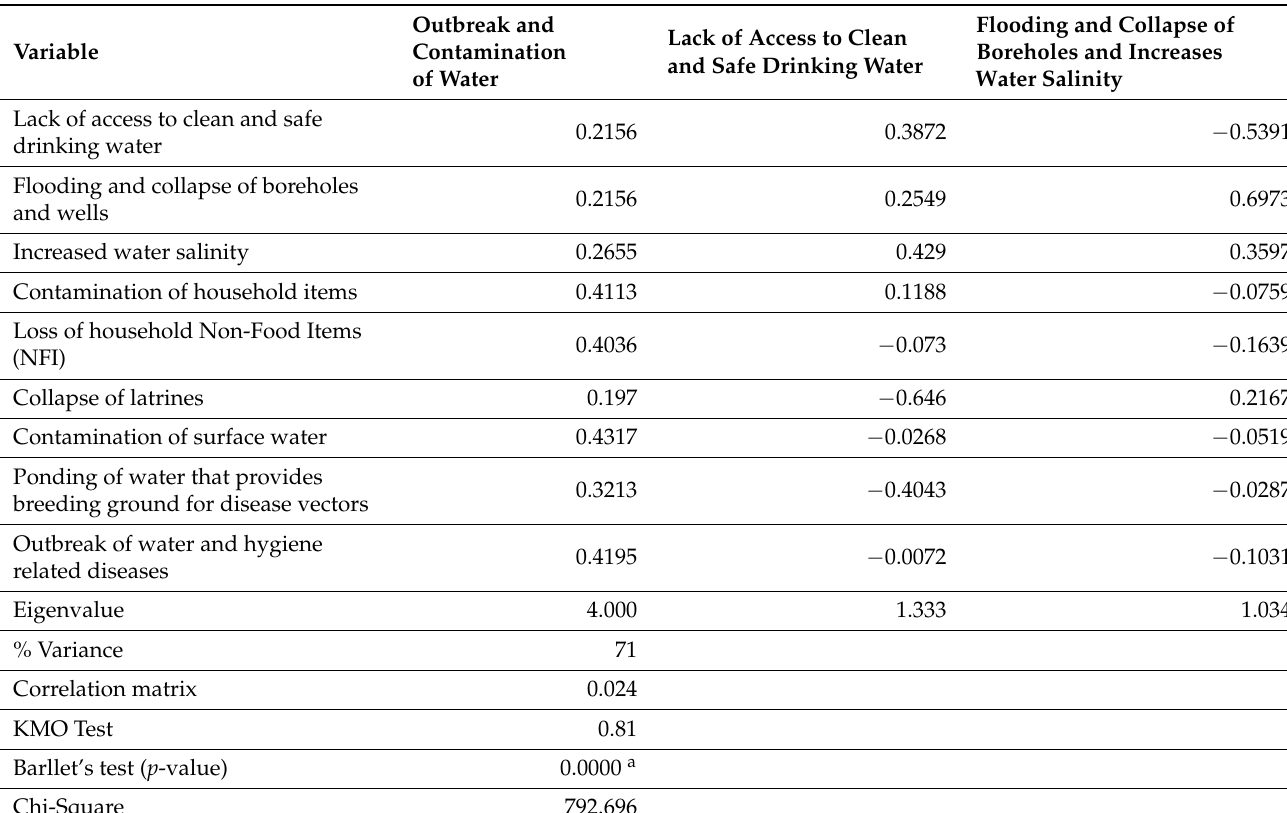
Table 2. Dimensions of experience of flood incidences-Principal component analysis